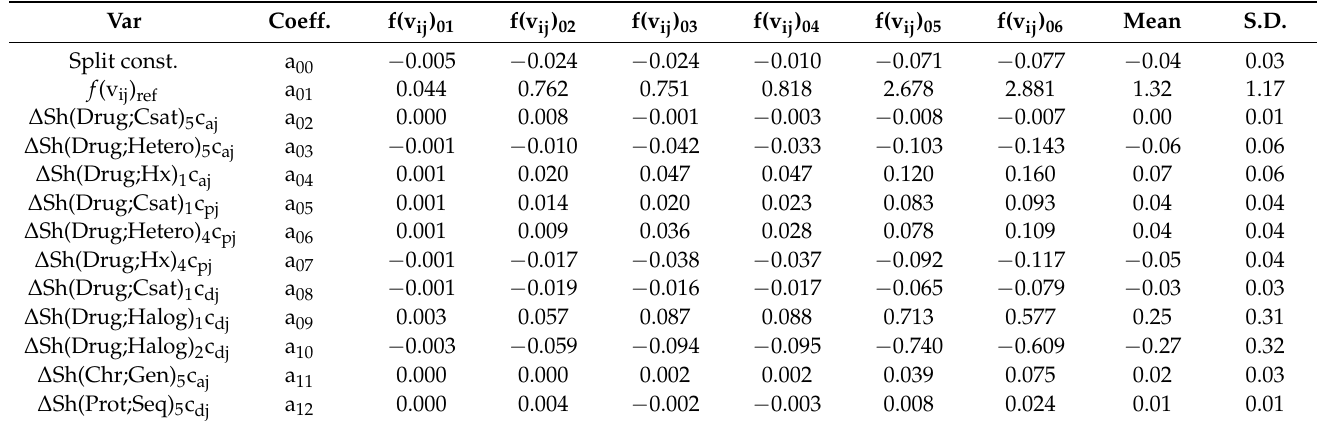
Table 4. IFPTML-CTLC model coefficients.